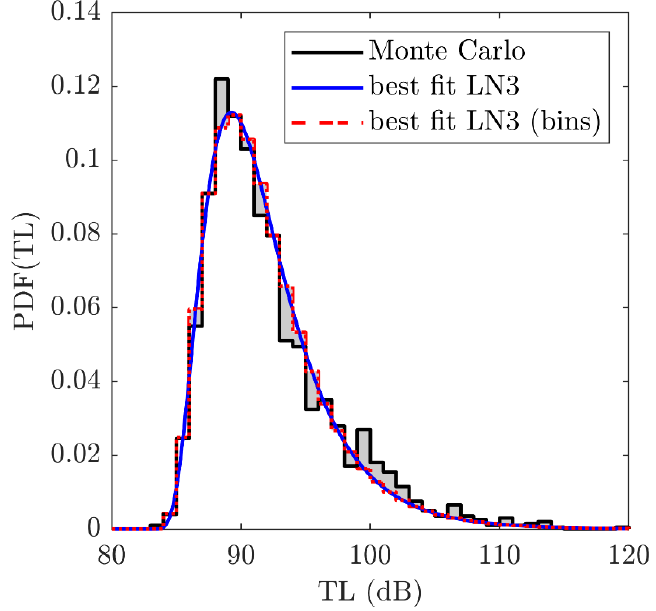
Figure 6. Example MC PDF of TL (solid black line) plotted with its best fit three-parameter log normal (LN3) PDF (solid blue line) and as a histogram (dashed red line). The L 1 error between the MC PDF of TL and its best fit LN3 PDF is visualized as the shaded region and is 0.105 in this example.